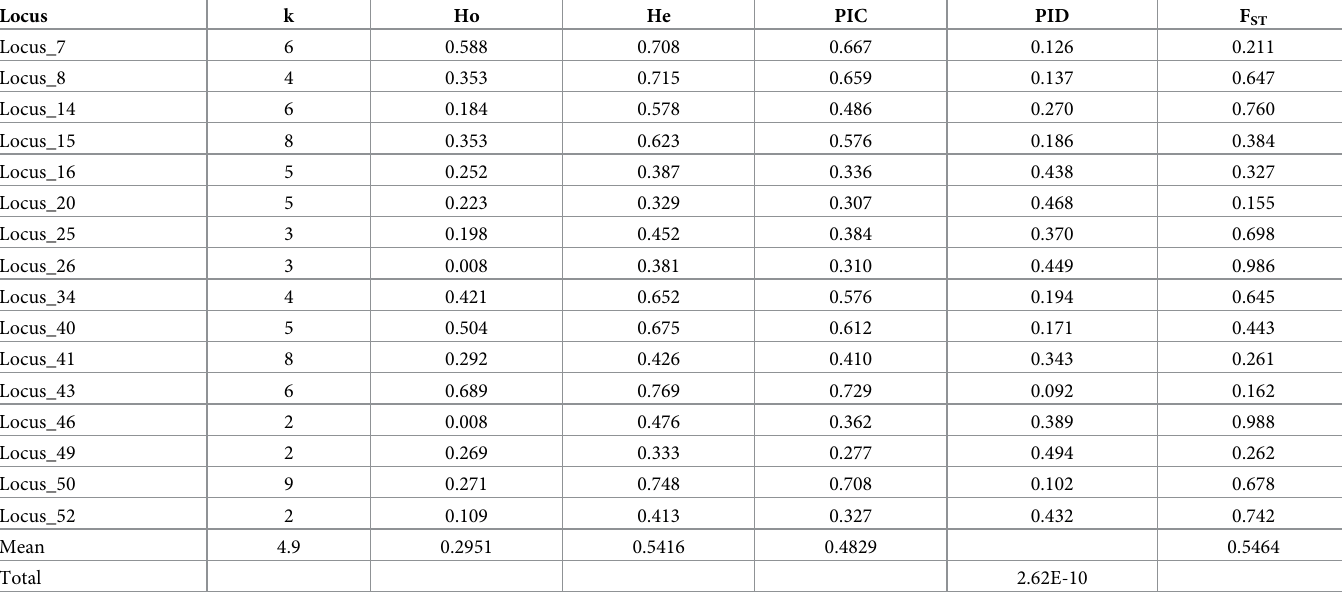
deer. The average Ho and expected He ranged from 0.2804 to 0.4574 and 0.2991 to 0.3855, respectively, across the three deer species. The mean PIC of all three species was > 0.25. PID ranged from 1.69E-05 to 6.42E-09, and PE ranged from 0.970 to 1 across the three species. The overall F ranged from -0.233 to 0.063 and showed no significant deviation from zero, indicat- IS ing that our tested samples were not closely related. Among the 55 markers, three markers showed polymorphism in one species but produced nonspecific amplicons in other species. Specifically, Locus_42 was polymorphic in Sambar and red deer but failed to be amplified in sika deer. Locus 44 and Locus_53 were polymorphic in Sambar and sika deer but produced nonspecific results in red deer. Overall, a total of 29 EST-SSRs displayed polymorphism in all three deer species (see S1 and S2 Tables for details). To increase efficiency and informativeness, we excluded markers with a PIC < 0.25. Finally, 16 EST-SSR markers were chosen for phylogenetic analysis and were further characterized (Table 3). In this set of 16 markers, the number of alleles per locus ranged from 2 to 9, Ho ranged Table 3. Summary data of 16 polymorphic EST-SSRs in 45 sambar, 30 sika deer, and 46 red deer. Locus k Ho